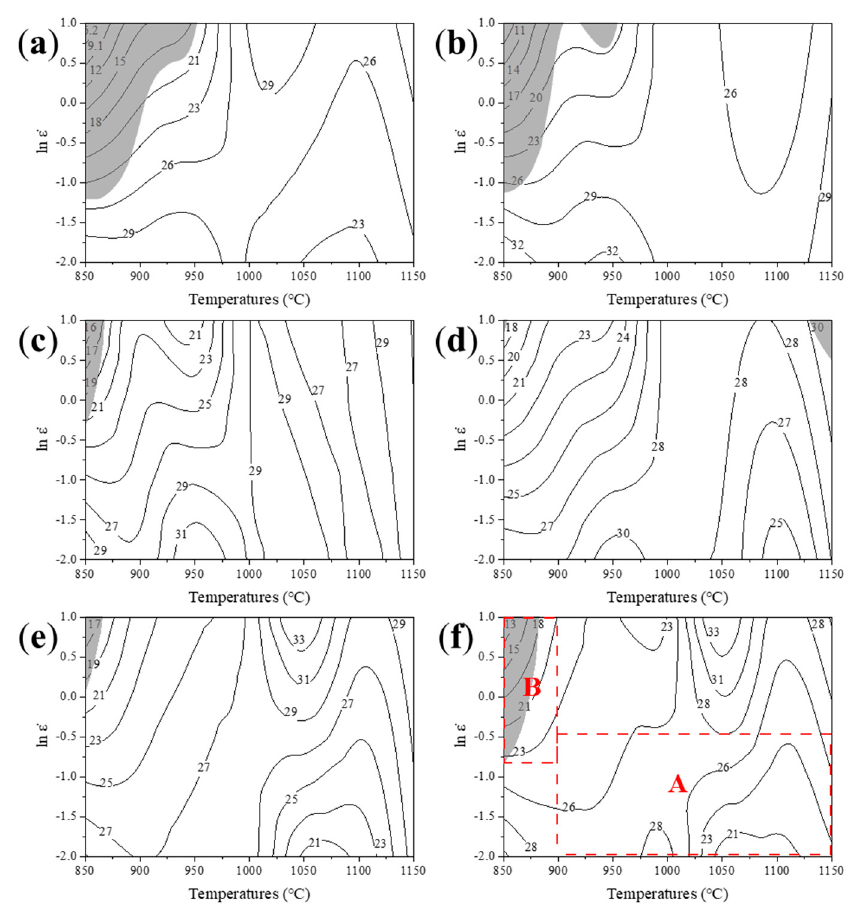
Figure 8 . Processing maps for Fe30Mn11Al1C0.1V0.1Nb low density steel at true strains of ( a ) 0.1, ( b ) 0.2, ( c ) 0.4, ( d ) 0.6, ( e ) 0.8 and ( f ) 0.9. The contour numbers represent iso-efficiency of power dissipation expressed in pct.